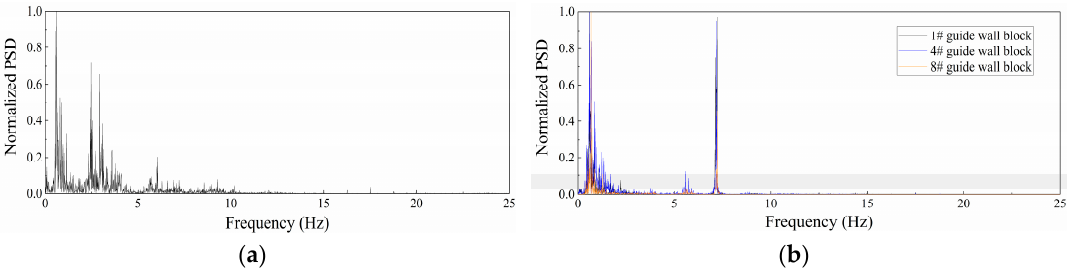
Figure 4. The comparison of FT spectrums of vertical displacements of the 1# dam block and typical guide wall blocks. ( a ) 1# dam block; ( b ) typical guide wall blocks. Table 1. Dominant frequencies of horizontal displacements in different parts of structures.